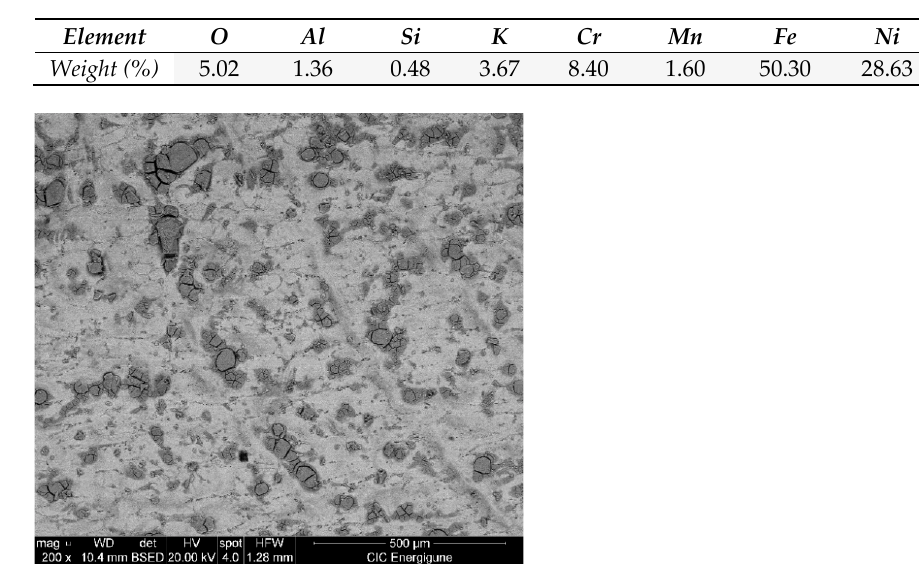
Figure 9. Superficial image of OC4 alloy after 500 h in KOH at 380 °C. Element